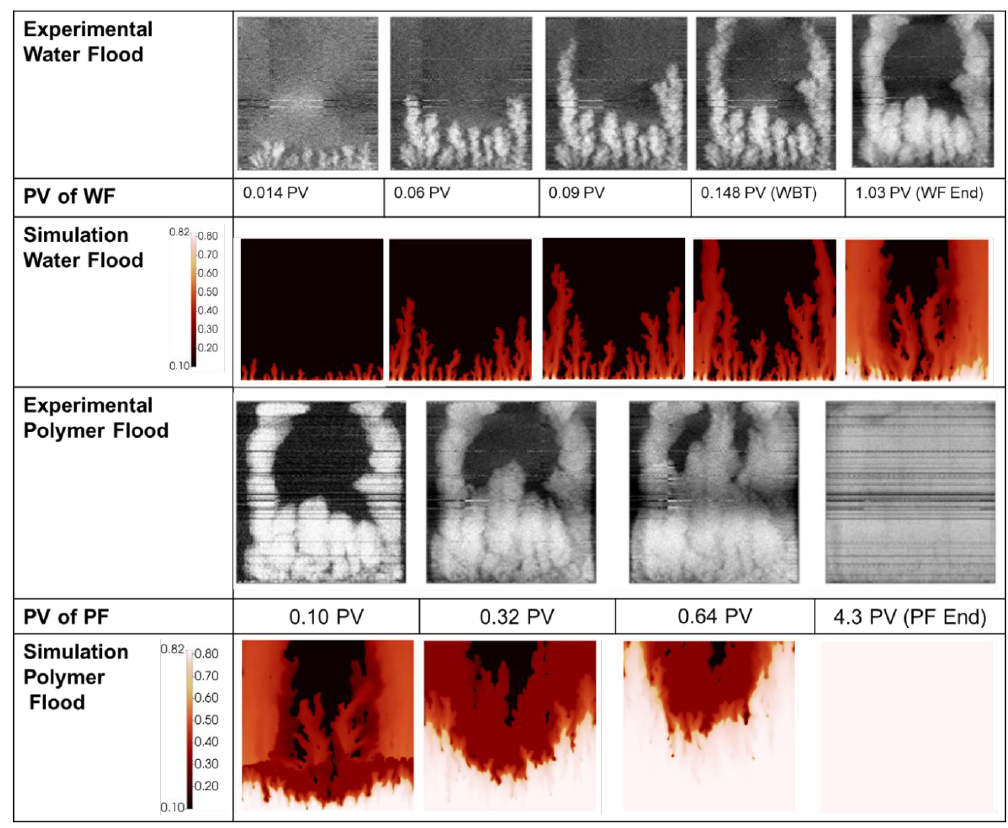
Figure 13. Experimental vs. simulated finger patterns during displacement of 412 mPa.s oil.